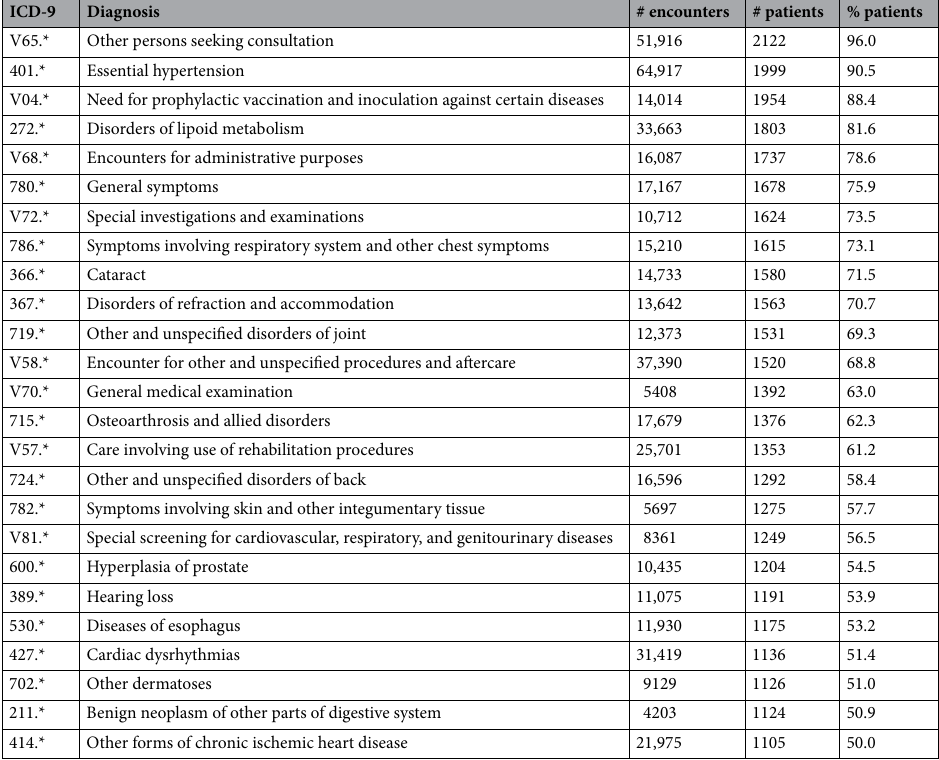
Table 2. Most common three-digit ICD diagnoses by EHR coding among CSP #380 participants (n = 857). Includes all diagnoses among patients in the VA Corporate Data Warehouse.